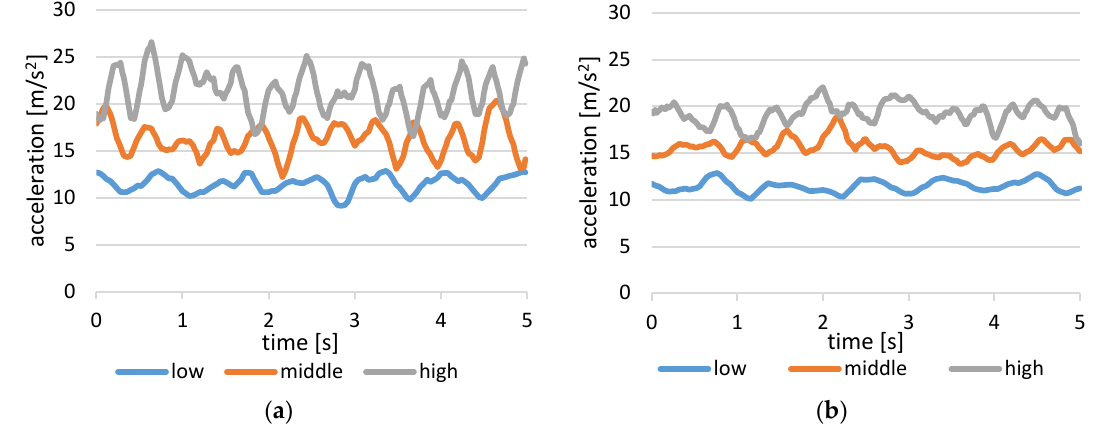
Figure 11. Time sequence results of the magnitude of the accelerations for each target speeds in condition “mute” followed by condition “sound”: ( a ) condition “mute”; ( b ) condition “sound”.